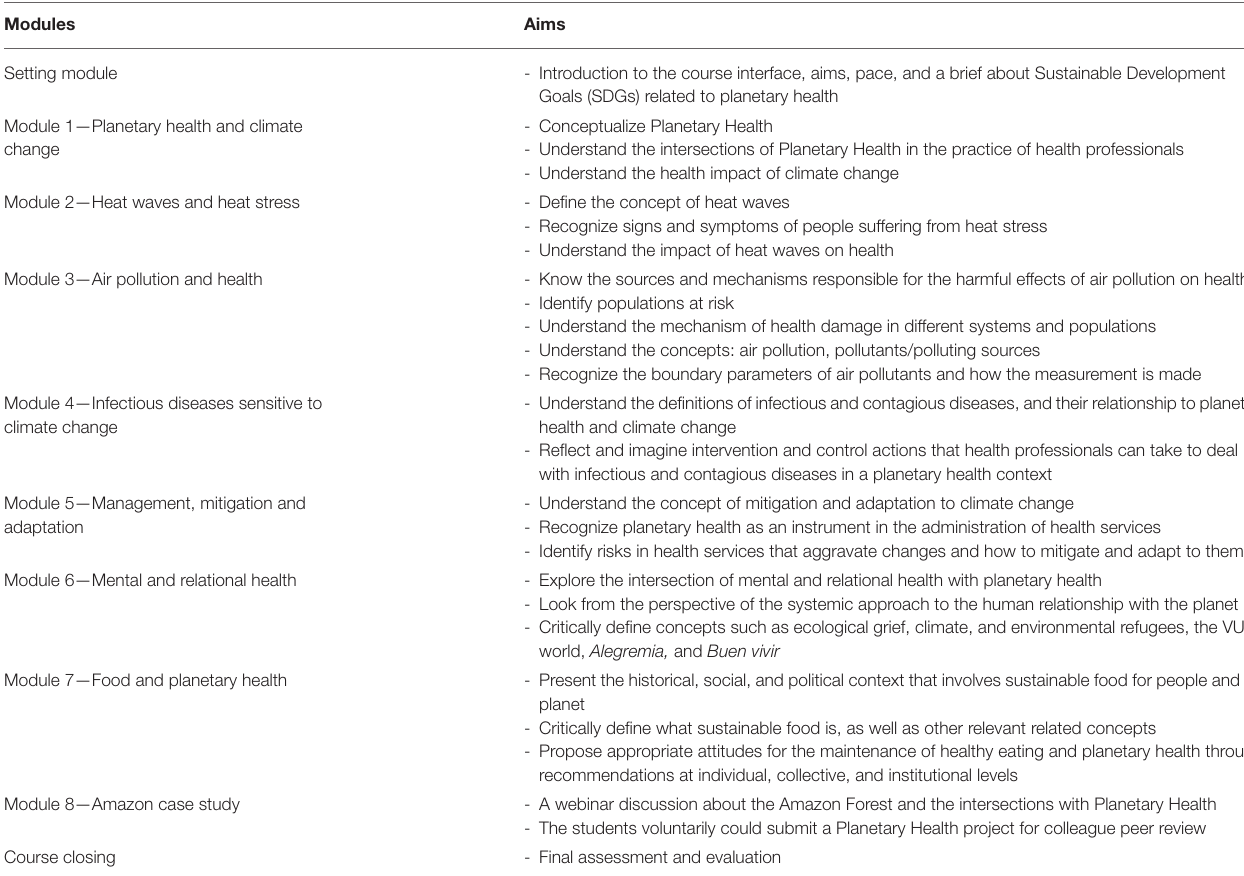
TABLE 1 | Planetary health course modules and aims.